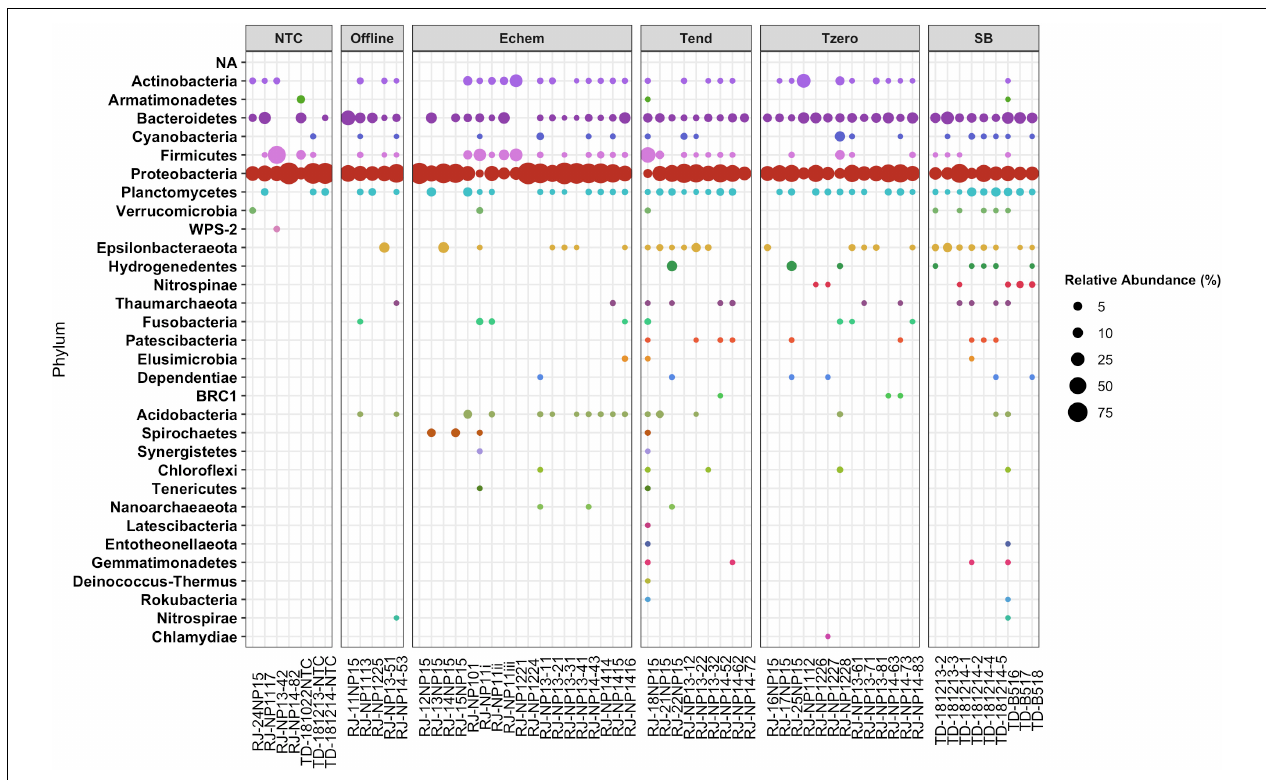
FIGURE 6 | Relative abundance of taxonomic groups at the Phyla level in poised potential experiment samples, based on 16S rRNA gene (V4–V5 hypervariable region) Illumina sequence data, with sample names matching those provided in Table 2 . Sample order grouped by Treatment type, and taxonomic groups sorted as taxa that appear at least once in a no-template-control blank DNA extraction versus those that do